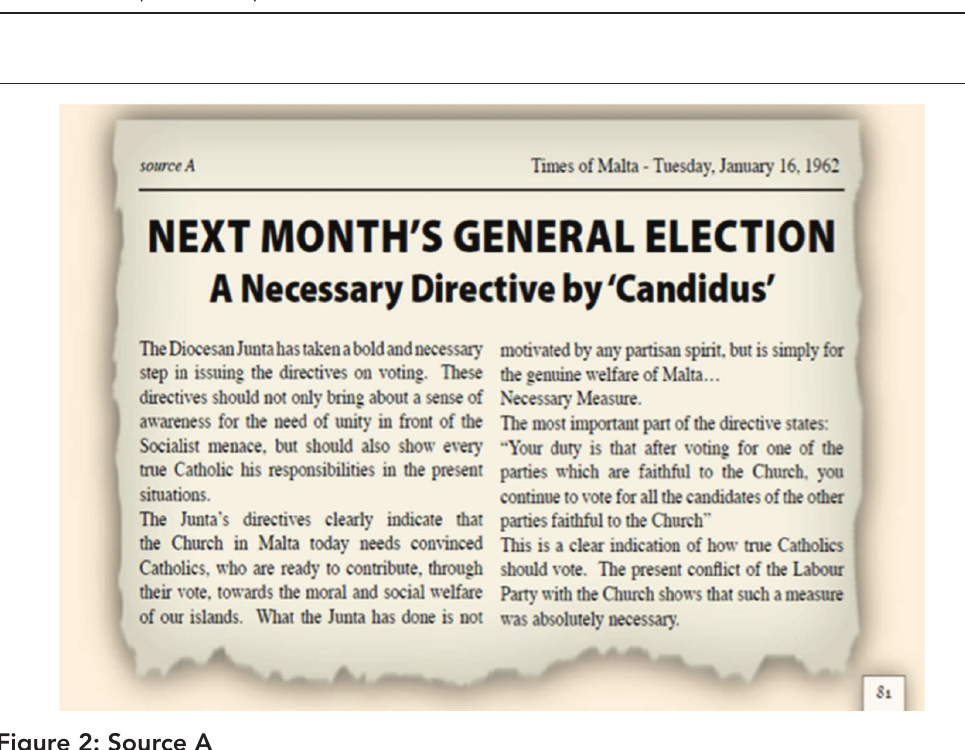
Figure 2: Source A Source : Vella (2008: